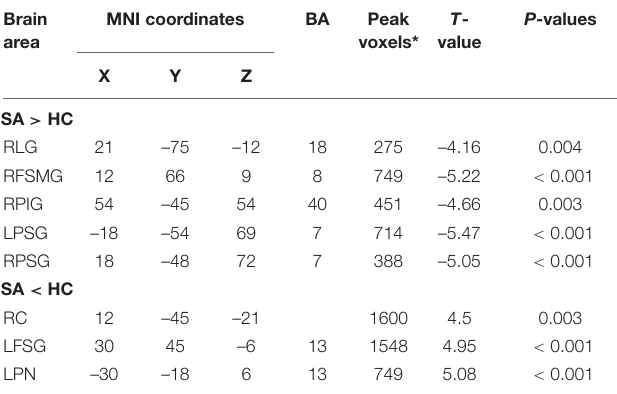
TABLE 3 | Brain areas with significantly different ReHo values between two groups.